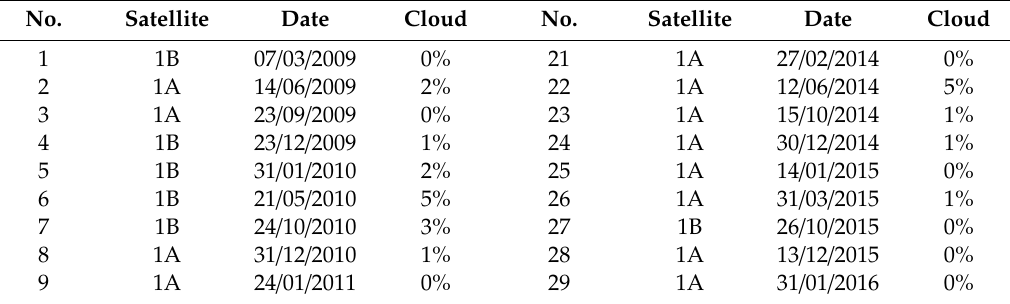
Table 2. Information of the time series data. 1A and 1B are HJ-1A and HJ-1B.